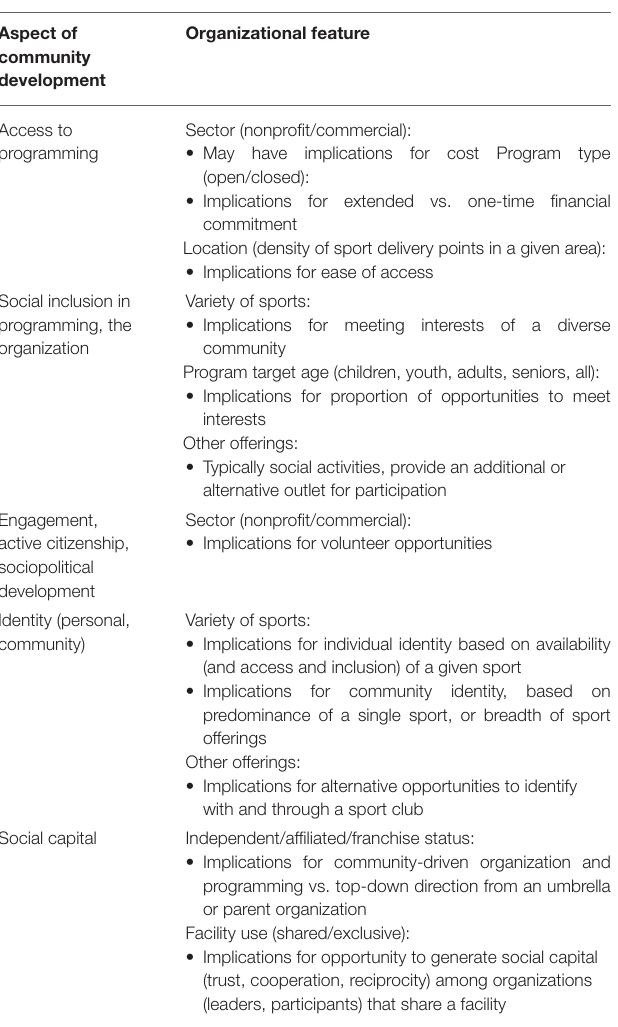
TABLE 1 | Conceptual alignment of aspects of community development and features of community sport organizations. Aspect of